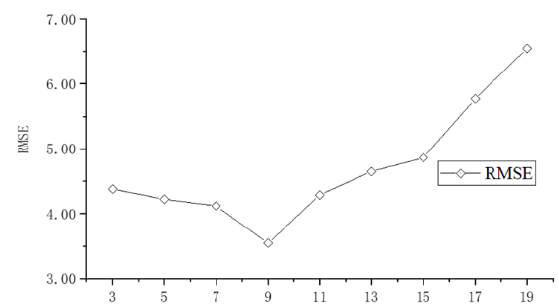
Figure 9. The relationship between RMSE and the sizes of